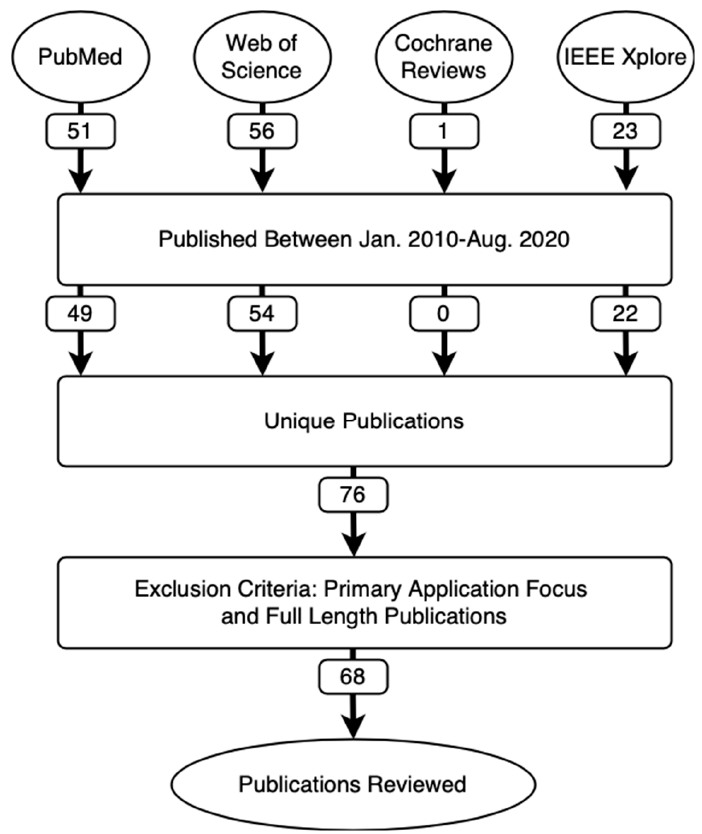
Figure A2. The description of the database keyword search results per database. Each number located within a square indicates the number of returned publications. The exclusion criteria are described in Section 2.